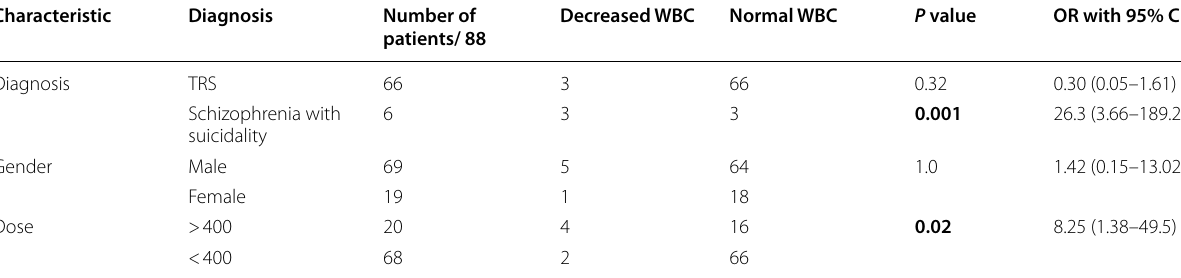
OR with 95% CI (odds ratio with 95% confidence interval)